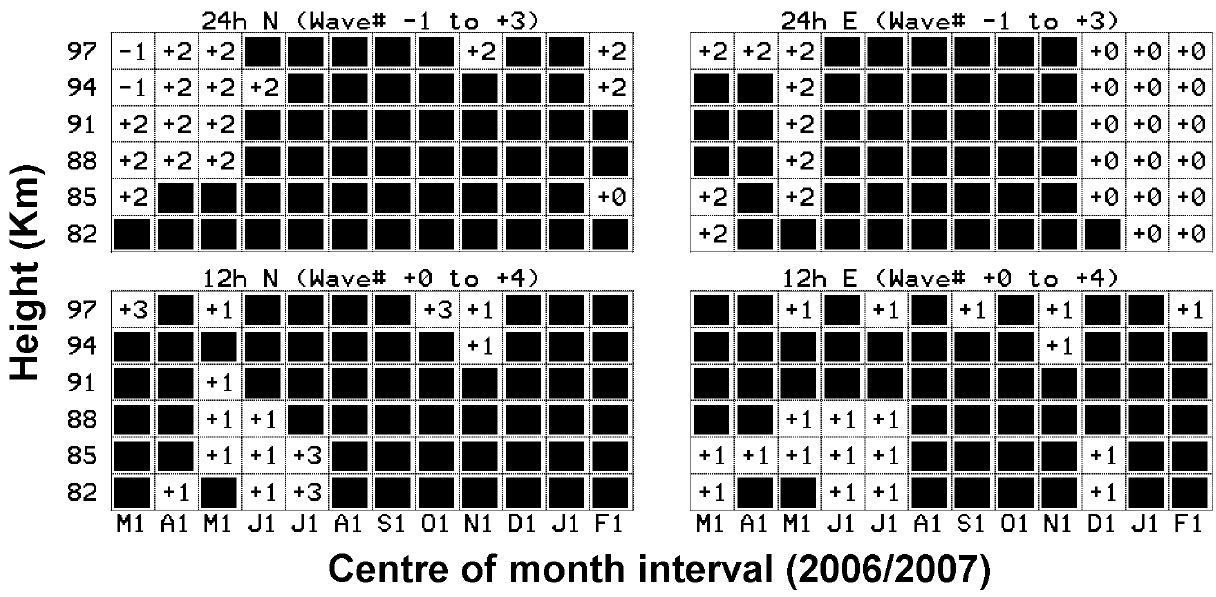
Fig. 9. Two-tide fits, using the wave numbers of the MT plus one of a range of NMT, were used to find the bigger: either the MT, which is shown here in black, or the NMT wave number in the ranges shown. The latter are appropriate to non-linear interaction with the SPW S =1 or